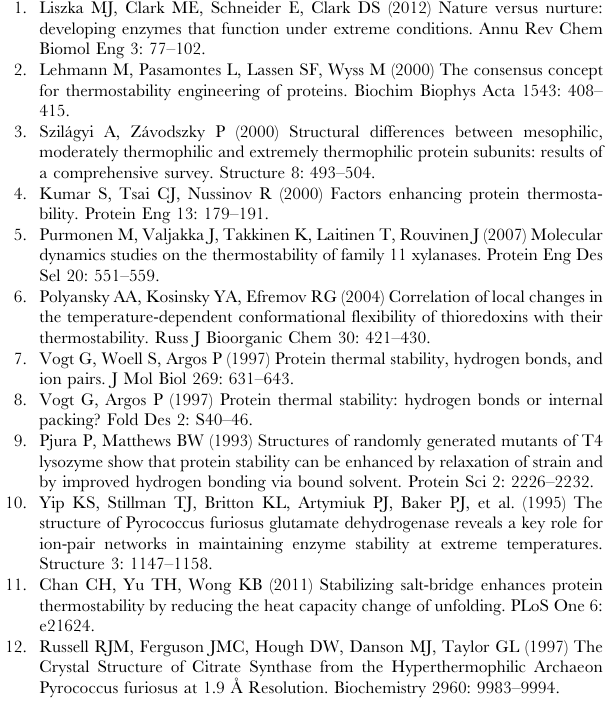
Figure S1 Multiple structural alignment of the six mutants and WT. WT (Green), DM (Magenta), TM (Cyan), Figure S2 Ring graph representations of the contacts Figure S3 Distance distribution of all the new contacts formed in the mutant 6B, that show considerable change in the MD simulation. Figure S4 RMSF of C a atoms after projection of WT (Black) and 6B (Red) 300 K simulation trajectories on their respective first principal components. Figure S5 Number of residues in different secondary structures in A) WT at 400 K B) 6B at 400 K C) WT at 500 K and D) 6B at 500 K. Figure S6 Average Fractional SASA values for WT, 2D9 and 6B at 400 K and 500 K. Table S1 Average Network Parameters for the PCNs. (PDF) Table S2 Residues with highest BC values. (PDF) Table S3 Ten residues in each mutant showing maxi- mum difference in the betweenness centrality.